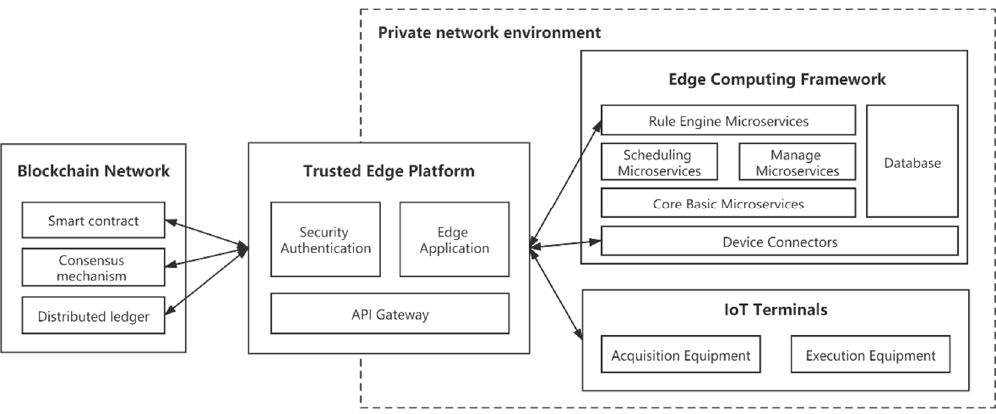
Figure 1. Edge Computing Environment Configuration.